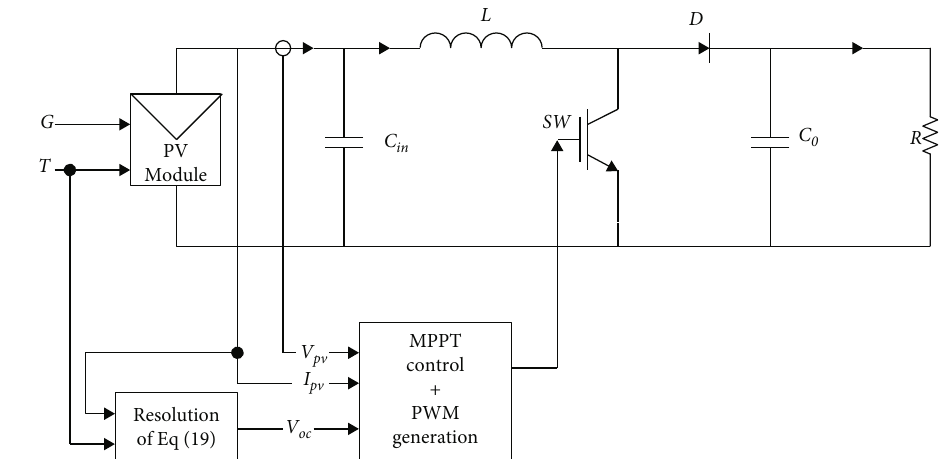
Figure 8: Electrical schematic diagram of the proposed enhanced